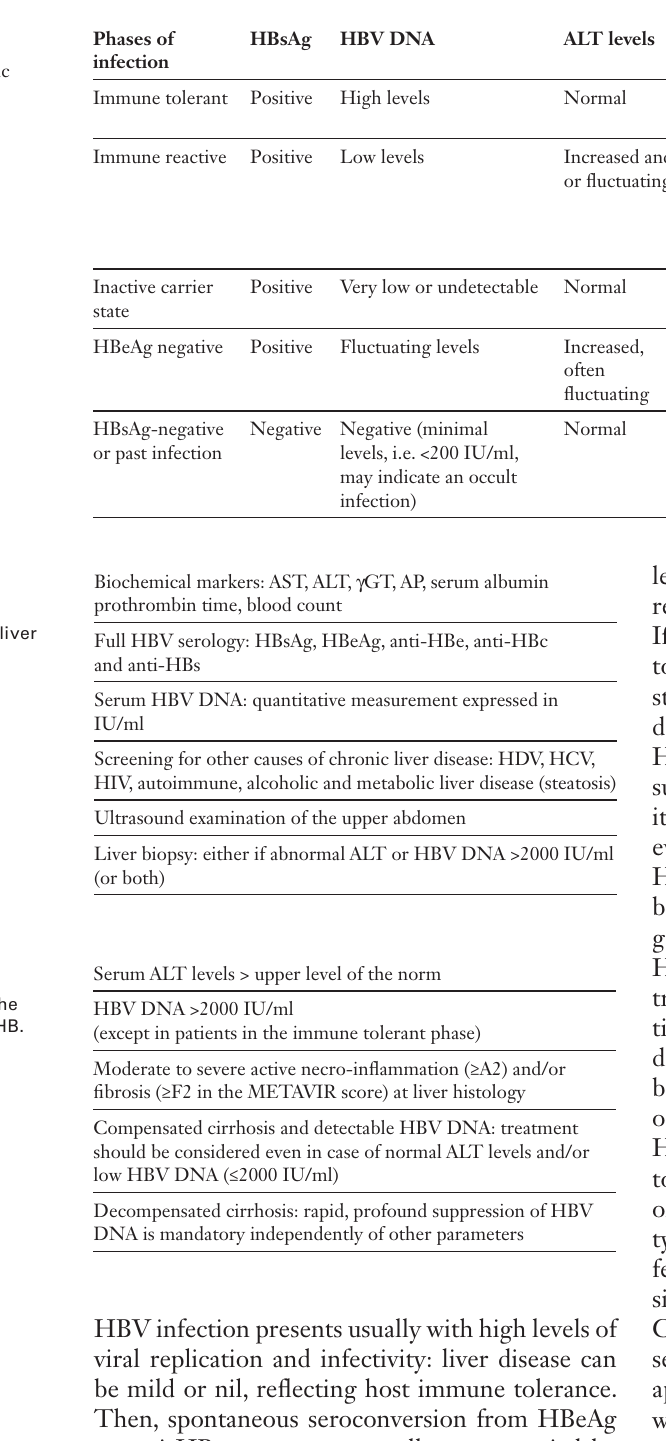
Phases of chronic HBV infection.